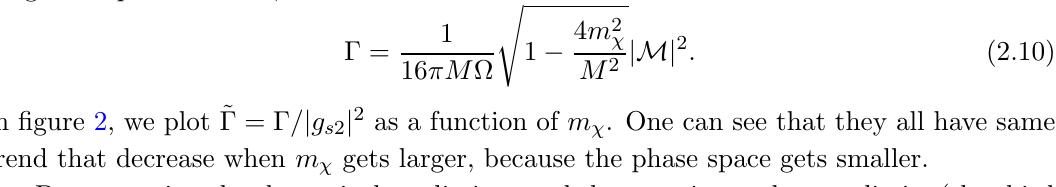
Figure 3. The experimental bounds of and (W) represents